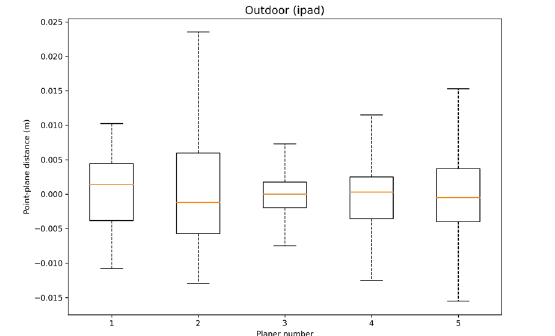
Figure 9 . Coverage of the surfaces by iPad Pro.